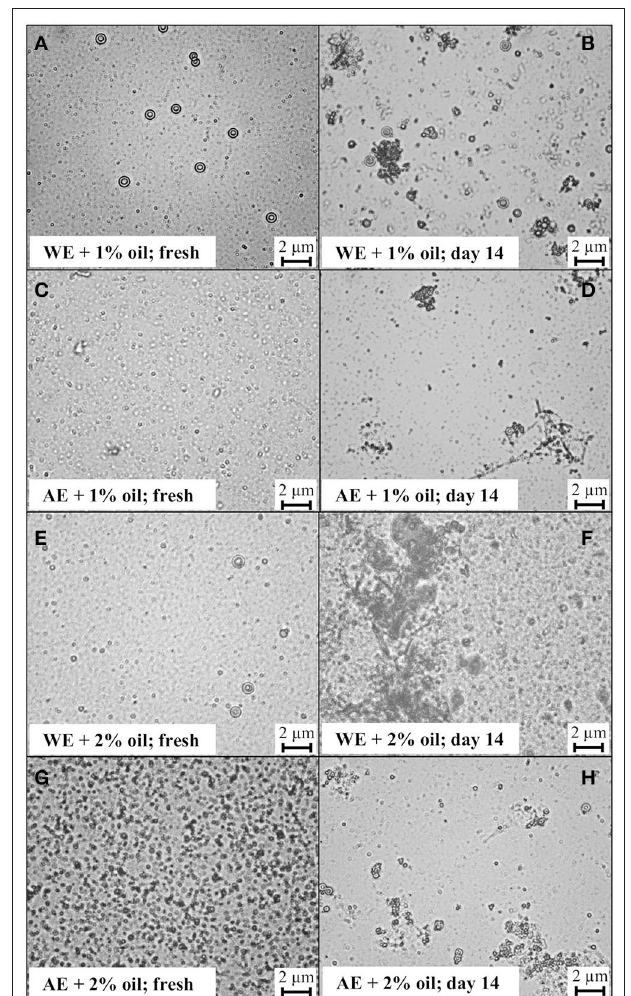
FIGURE 6 | Optical microscopic images of emulsions with 1% water extract (WE) and 1% (A,B) or 2% (E,F) oil and emulsions with 1% alkaline extract (AE) and 1% (C,D) or 2% (G,H) oil. Images were taken from fresh emulsions (A, C, E, G) and after 14 days of storage (B, D, F, H) at RT. The scale bar is 2 µ m and all presented images are at the same